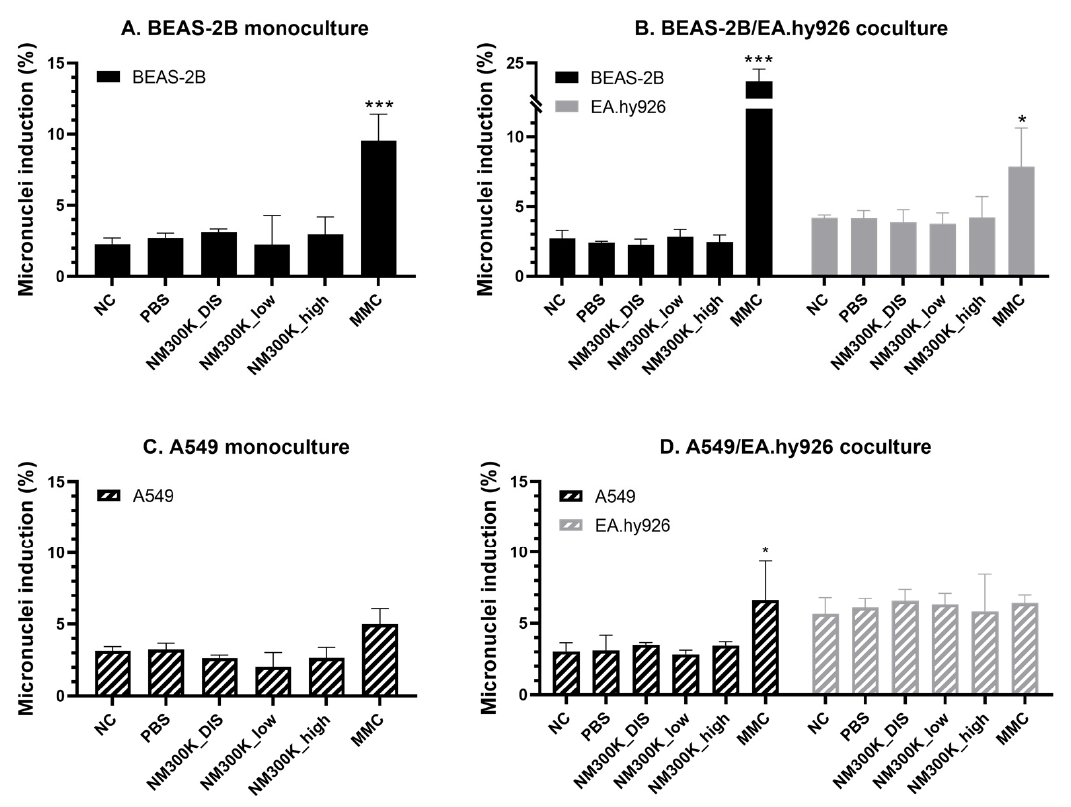
Figure 7. Micronuclei induction in BEAS-2B, EA.hy926 and A549 cells after exposure to aerosolized NM-300K and control solutions at the air–liquid interface, evaluated by the cytokinesis block mi- cronuclei assay. Micronuclei induction was analyzed in cells from BEAS-2B monoculture ( A ), BEAS- 2B/EA.hy926 coculture ( B ), A549 monoculture ( C ), and A549/EA.hy926 coculture ( D ). Results are presented as the mean with standard deviation from single or duplicate inserts from n = 3 independent experiments. Statistically significant different effects on micronuclei induction compared to control inserts with PBS-exposed cells (PBS) were analyzed by one-way ANOVA followed by Dunnett ´ s post-hoc test (* p < 0.05, *** p < 0.001). NC: negative incubator control, PBS: phosphate-buffered saline, NM-300K DIS: dispersant control, NM-300K low: nominal 1 µ g/cm 2 , NM-300K high: nominal 10 µ g/cm 2 , MMC: mitomycin-C at 0.15 µ g/mL in basolateral medium for 24 h.